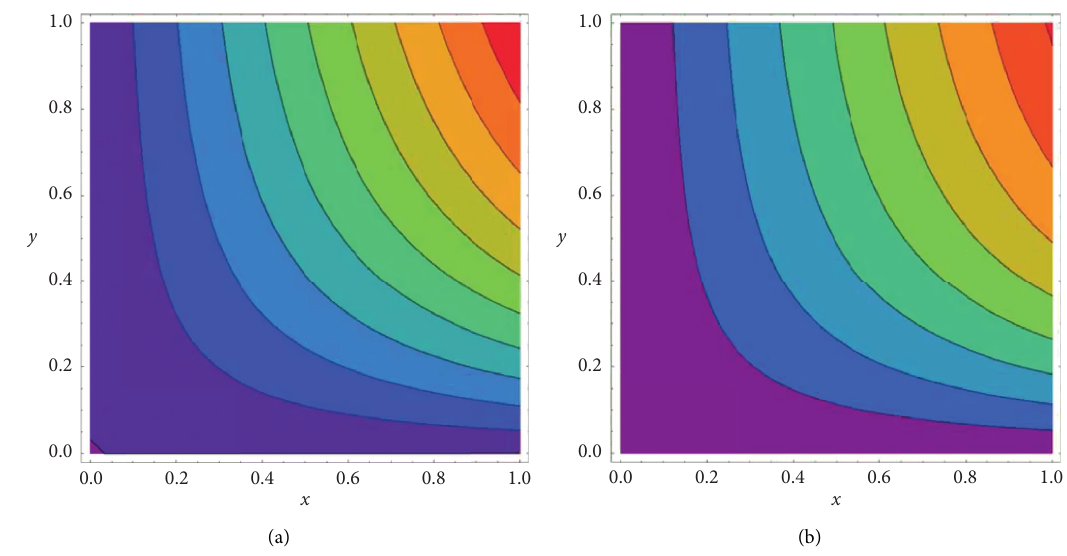
Figure 8: (a) Stream lines for M � 0.5. (b) Stream lines for M � 1.0.